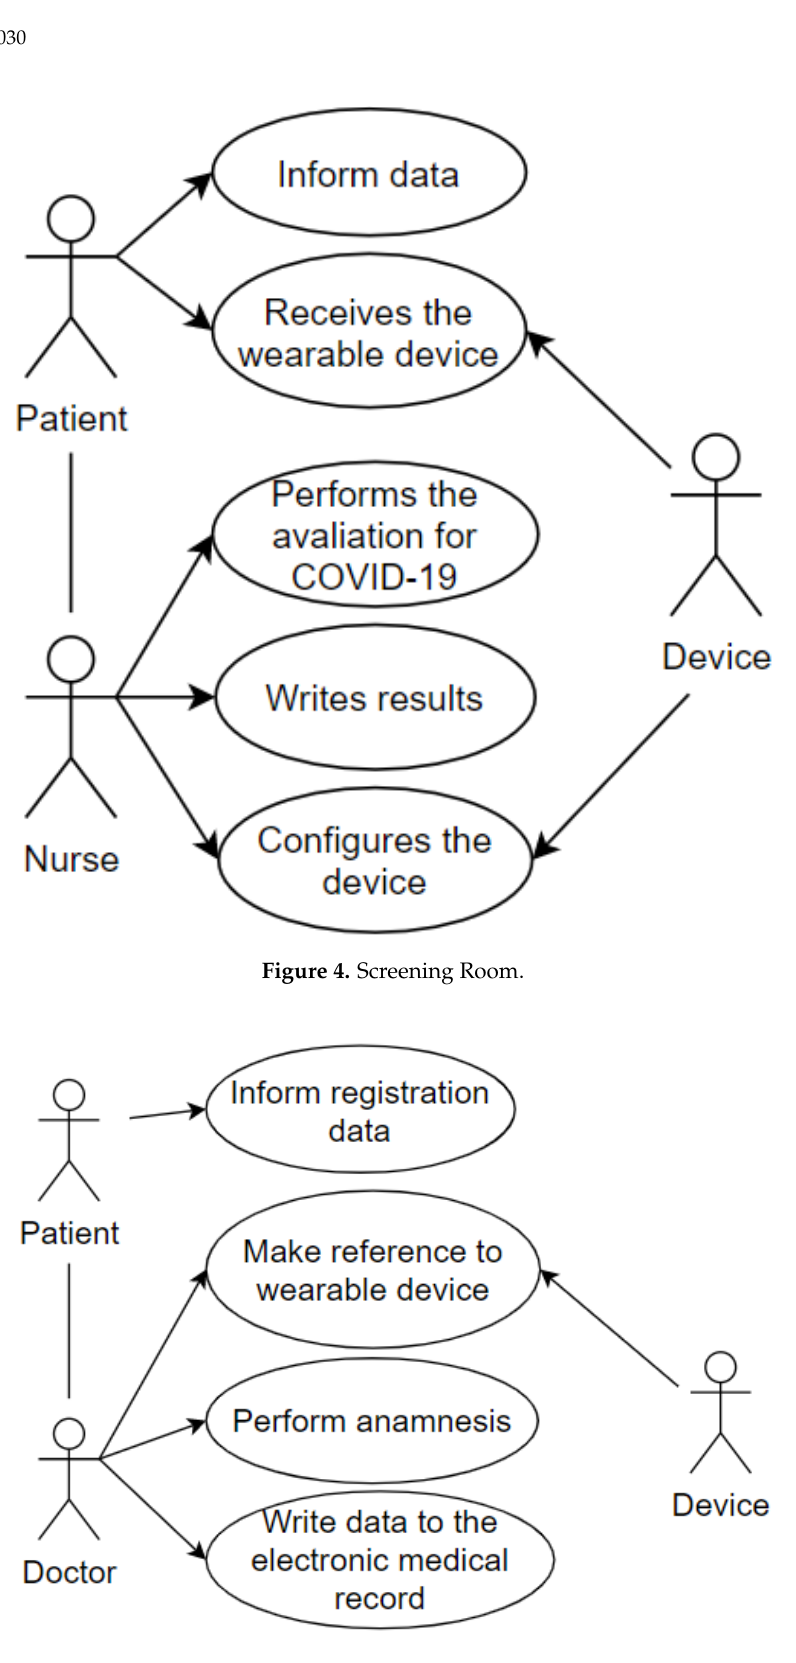
Figure 5. Reception at the